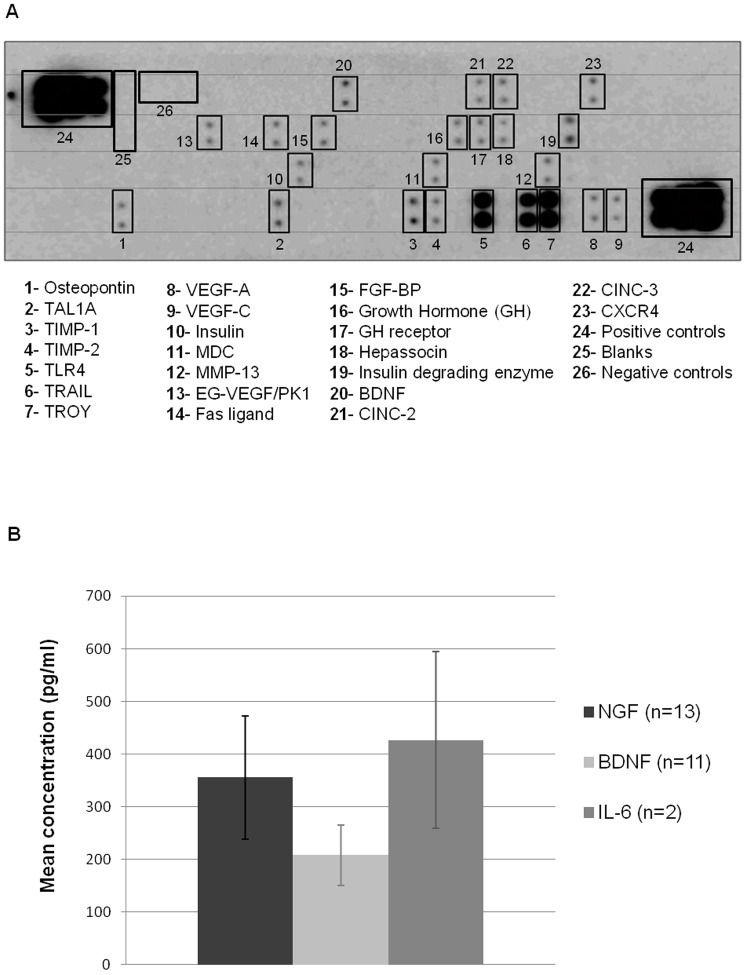
BMSC-CM characterization by antibody arrays and ELISA.(A) Multiple array membrane incubated with BMSC-CM reveals the presence of hormones, proteases, cytokines and trophic factors. Experiment was repeated 3 times. (B) Concentrations of NGF, BDNF and IL-6, measured by ELISA, within BMSC-CM. Experiment was repeated 2 to 13 times.